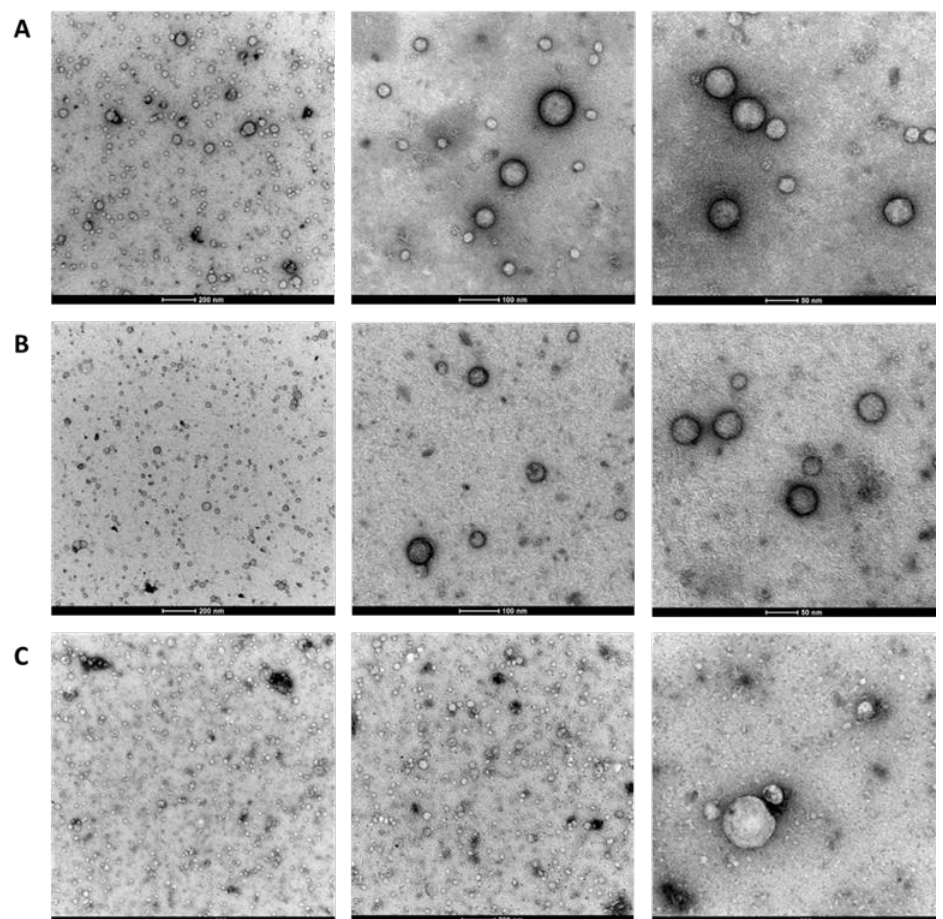
Figure 2. Representative TEM images of the isolated EVs. IIM patient (n = 1) ( A ), HD (n = 1) fresh samples (dilution 1:10) ( B ), and IIM patient (n = 1) after freeze (8 months) and thawed sample cycle (undiluted) captured at high magnification ( C ) (scale bar: 50 nm; 100 nm; 200; and 500 nm).